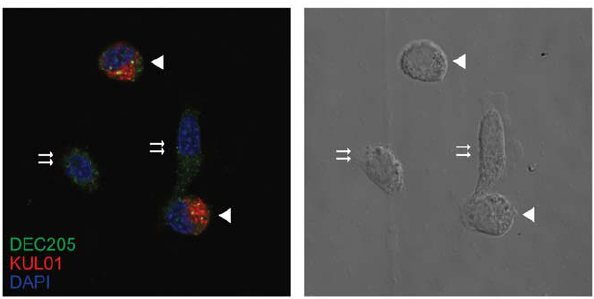
Figure 7. Distinct populations of adherent splenocytes ex- pressing DEC205. Adherent spleen cells were stimulated with LPS for three hours, then permeabilised and stained with FG9 anti DEC205 antibody (green, Alexa Fluor 488) and KUL01 monocyte/macrophage marker (red, Alexa Fluor 568). Nuclei were stained with DAPI (blue). The left panel shows the pseudocolour image from the confocal micro- scope, and the right panel shows a differential interference contrast image of the same cells. KUL01 positive cells with rounded morphology are indicated with large arrowheads and KUL01 negative cells with flattened and extended morphology are indicated with double arrows.